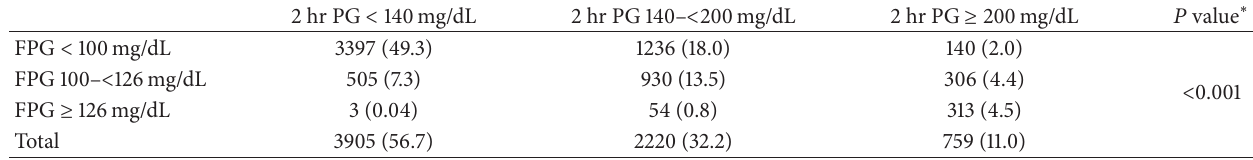
Table 2: Number (percentage) of participants according to glycemic status classified by FPG and OGTT.